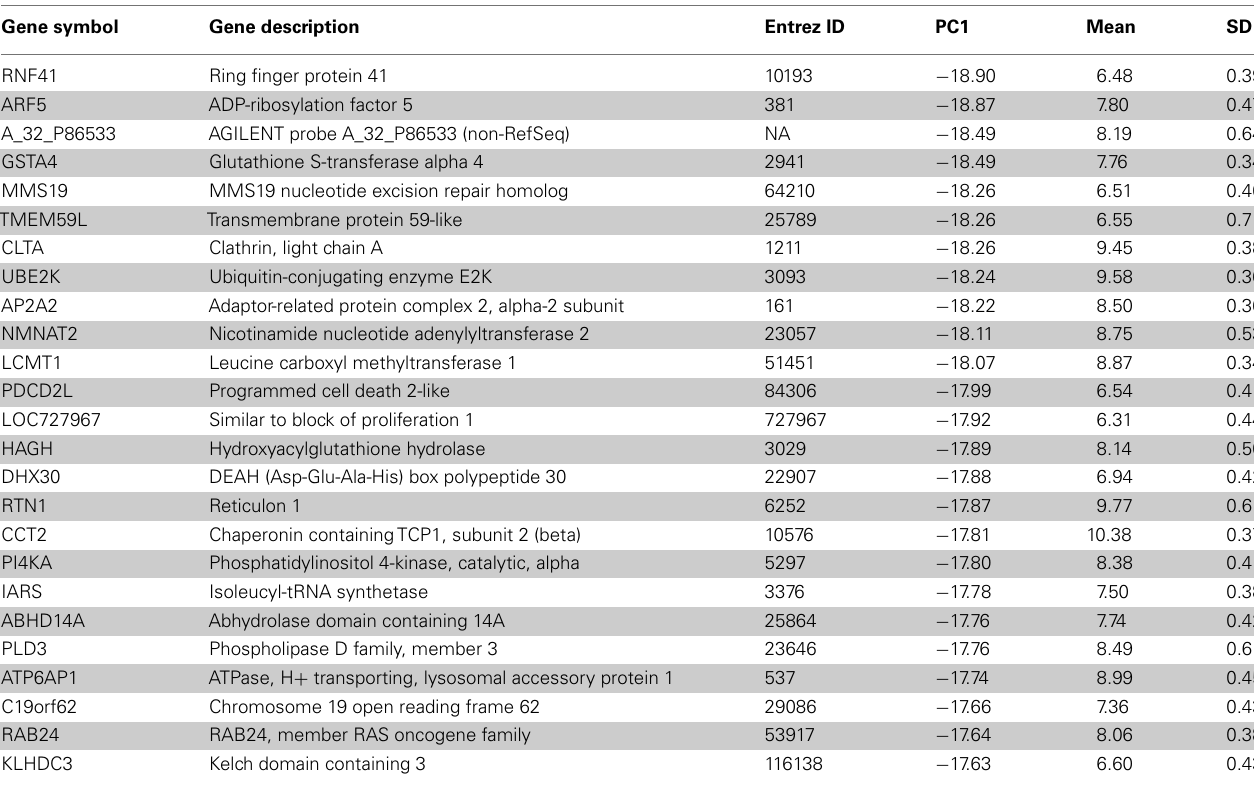
Table 2 |Top 25 genes in the neuron-enriched gene set of human H0351.2001 sorted by PC1 score. Gene